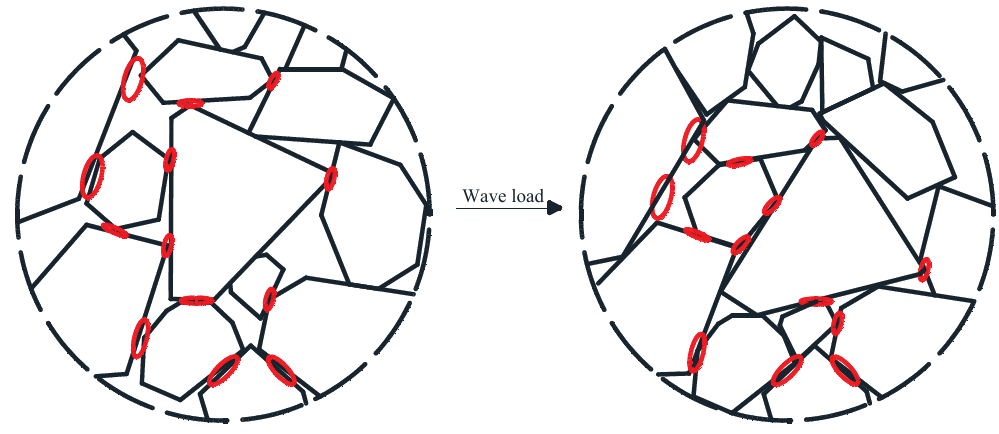
Figure 11. The Compression of clayey soil.